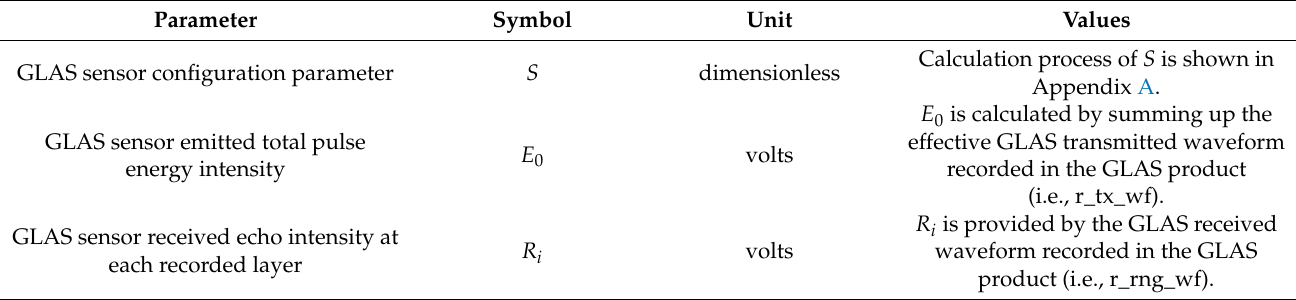
Table 2. The instrument parameters and waveform information of the GLAS lidar. Parameter Symbol Values GLAS sensor configuration parameter dimensionless